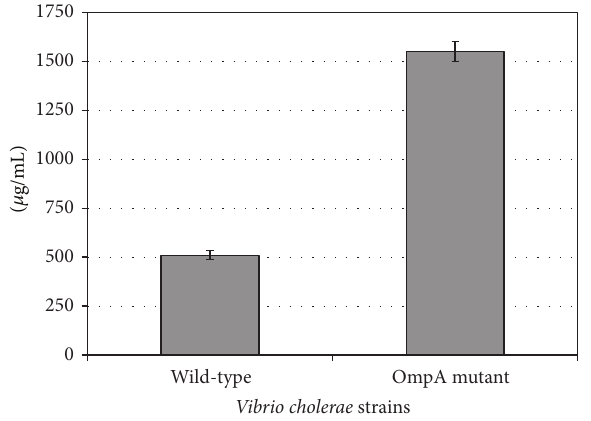
Figure 5: Production of outer membrane vesicles by V. cholerae wild-type and OmpA mutant strains. Data represent mean ± SD from three different measurements.